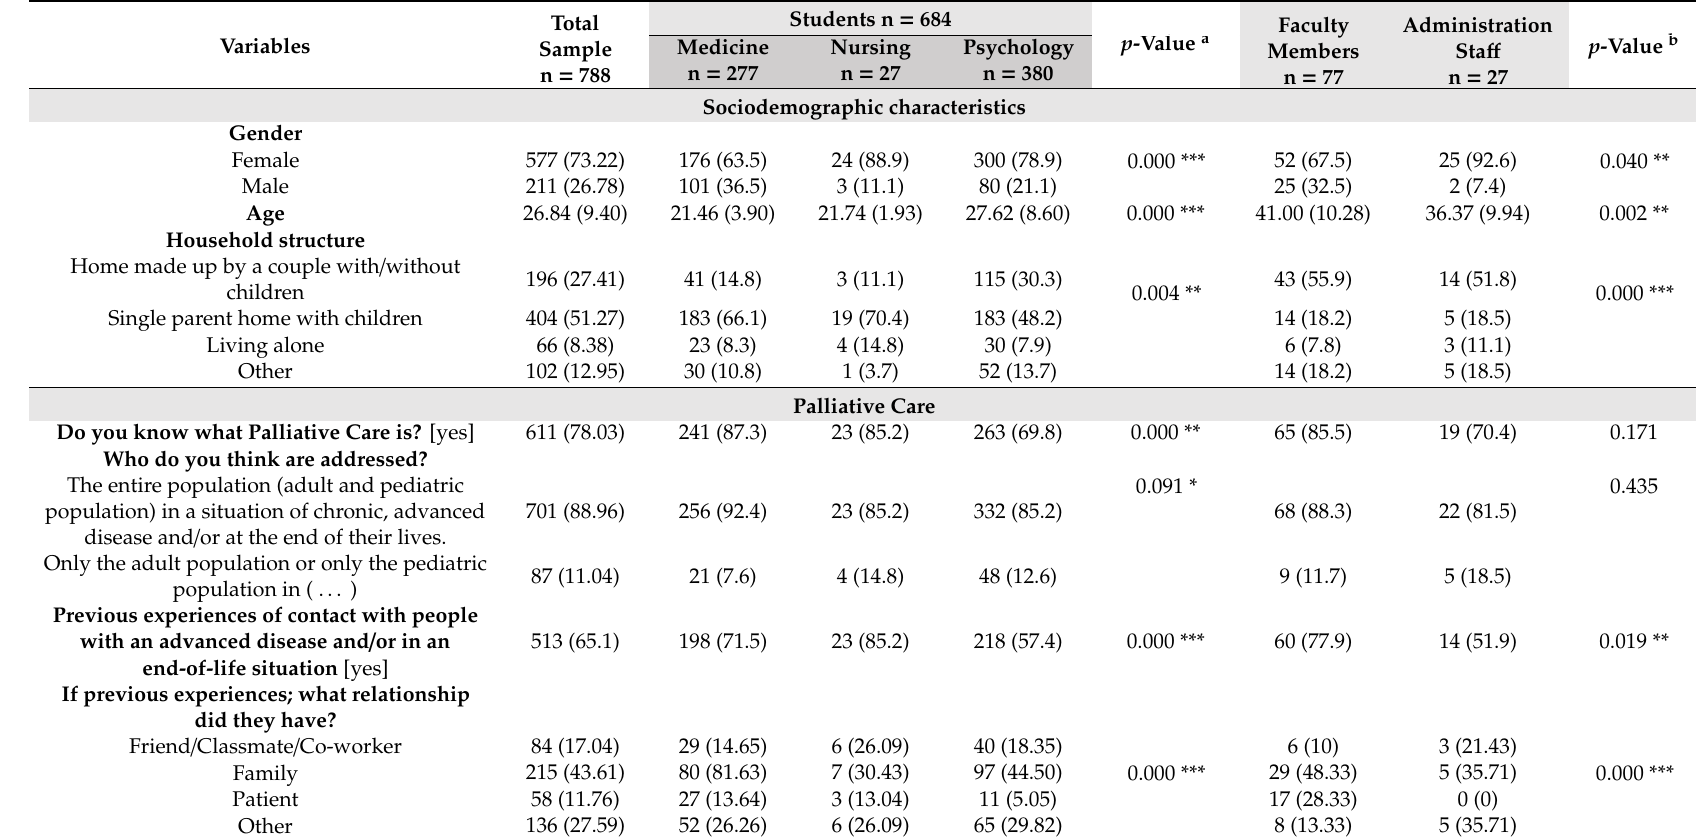
Table 1. Characteristics of the subjects and general aspects about Palliative Care (n =